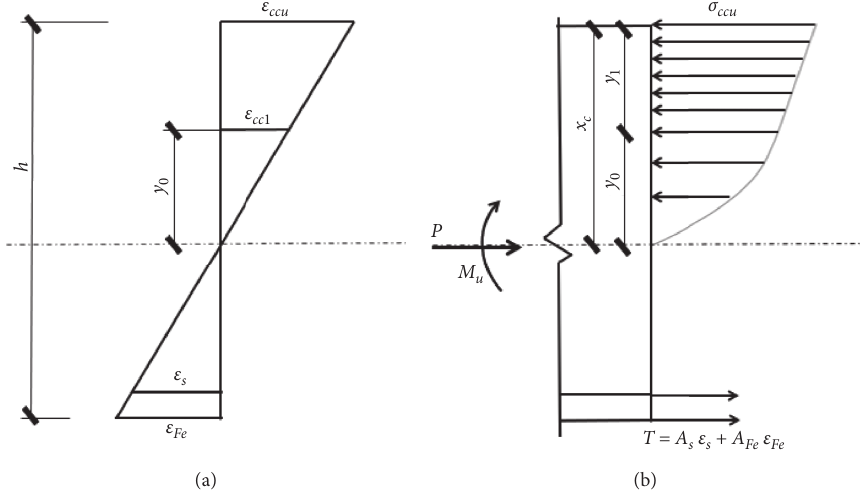
Figure 6: Cross-sectional strain and stress distribution.